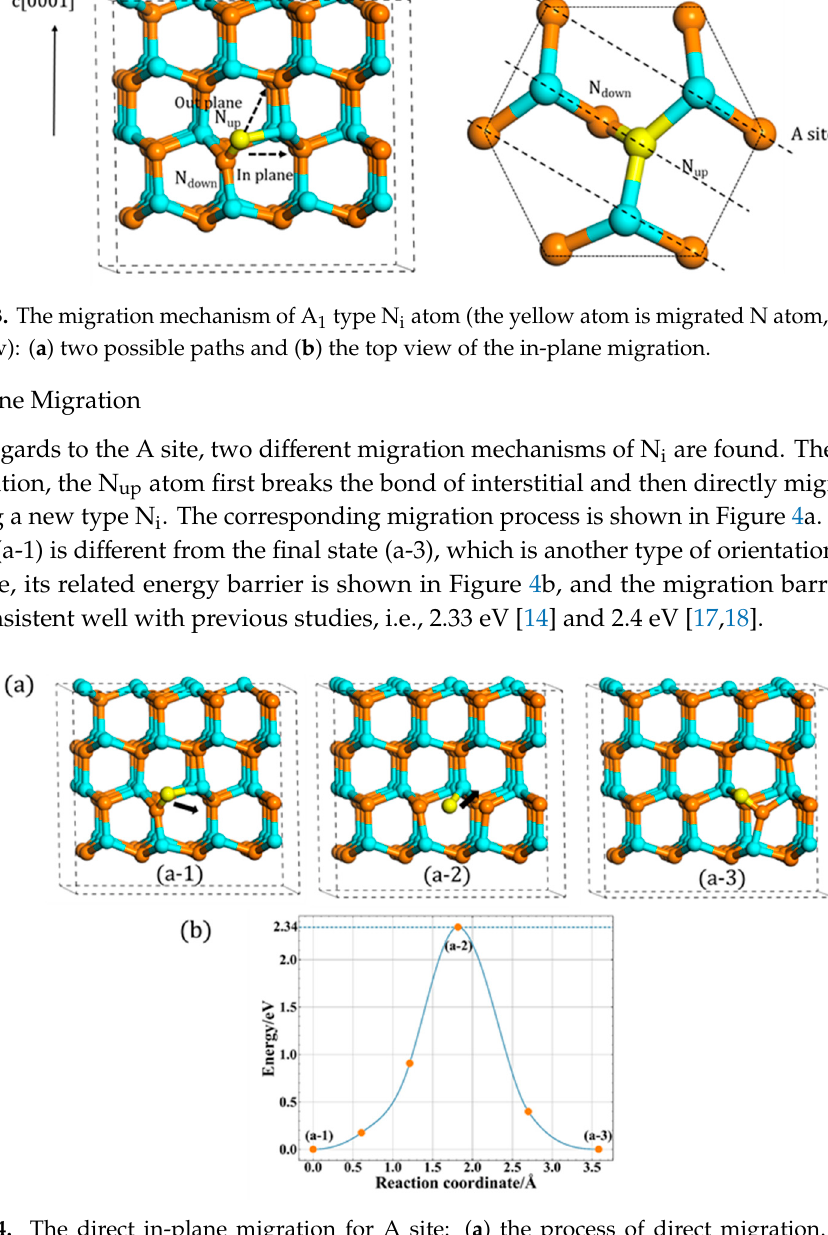
Figure 4. The direct in-plane migration for A site: ( a ) the process of direct migration. ( b ) The corresponding energy barrier (the solid dots are interpolated points and the solid line show the energy path obtained from CI-NEB methods).